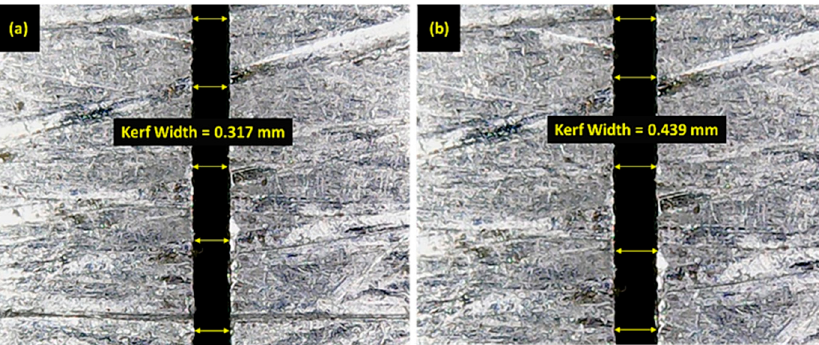
Figure 4. Kerf width at ( a ) 1 and ( b ) 4 A.